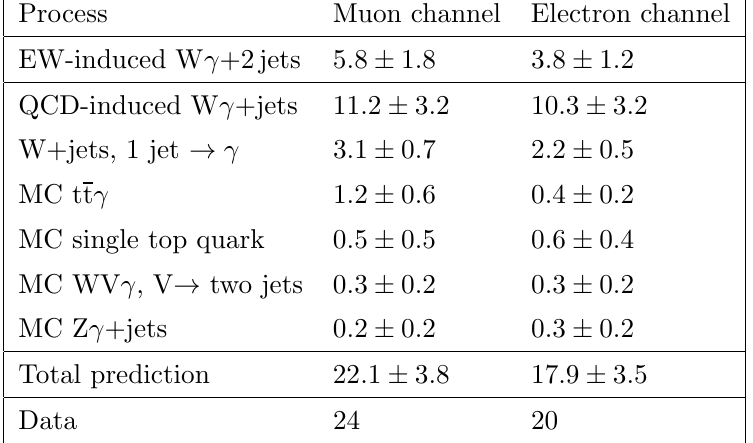
Table 2 . Number of events for each process, with combined statistical and systematic uncertainties. The total prediction represents the sum of all the individual contributions. The W+jets background, with one jet misidenti(cid:12)ed as an electron, is negligible in the signal region. the expected signal yield. Combining four m bins from the two decay channels gives an jj upper limit of 4.3 times the SM EW prediction at a 95% con(cid:12)dence level (CL), compared to an expected limit of 2.0 from the background-only